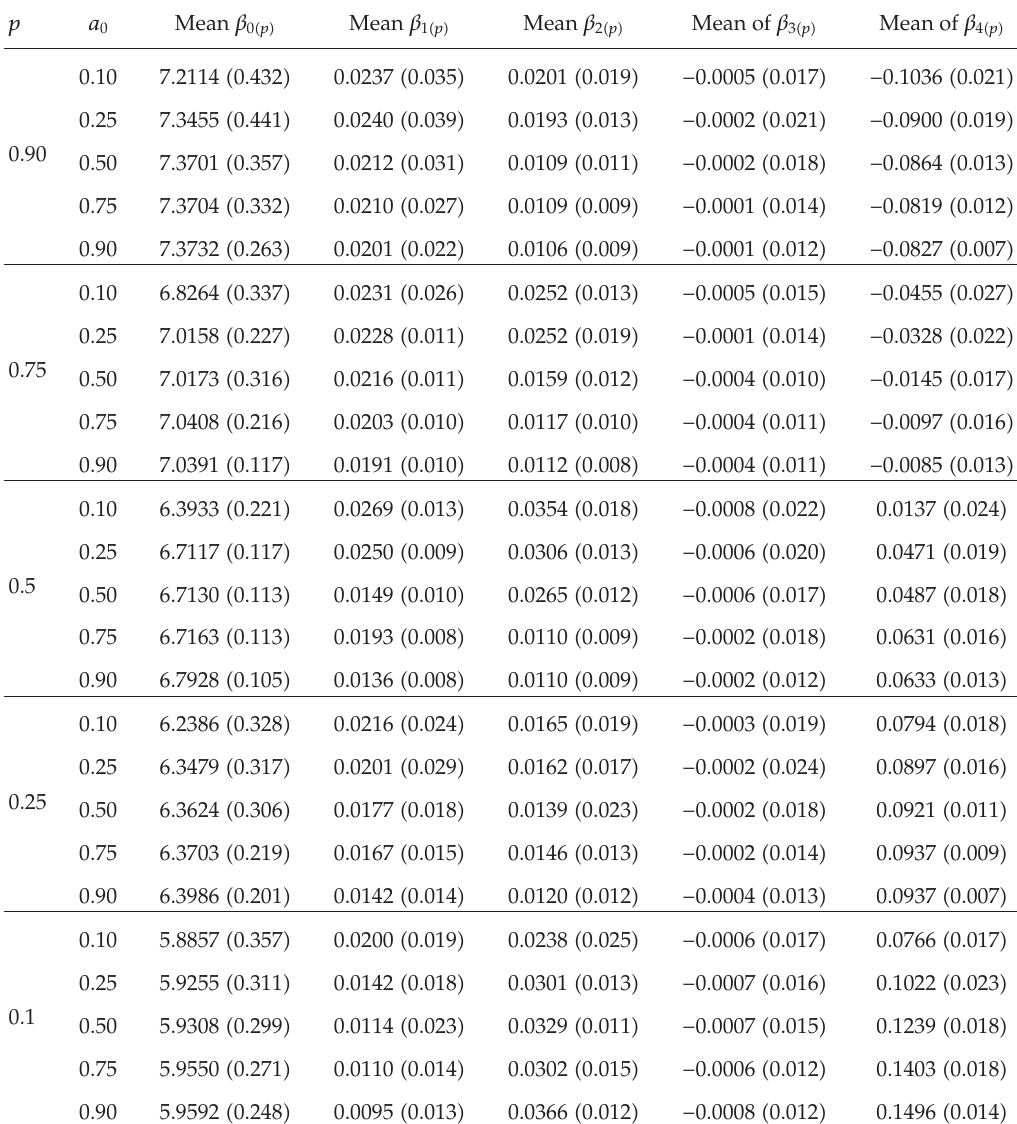
Table 3: Posterior means of β (cid:2) p (cid:5) for the real data. In the parentheses are standard deviations of β p